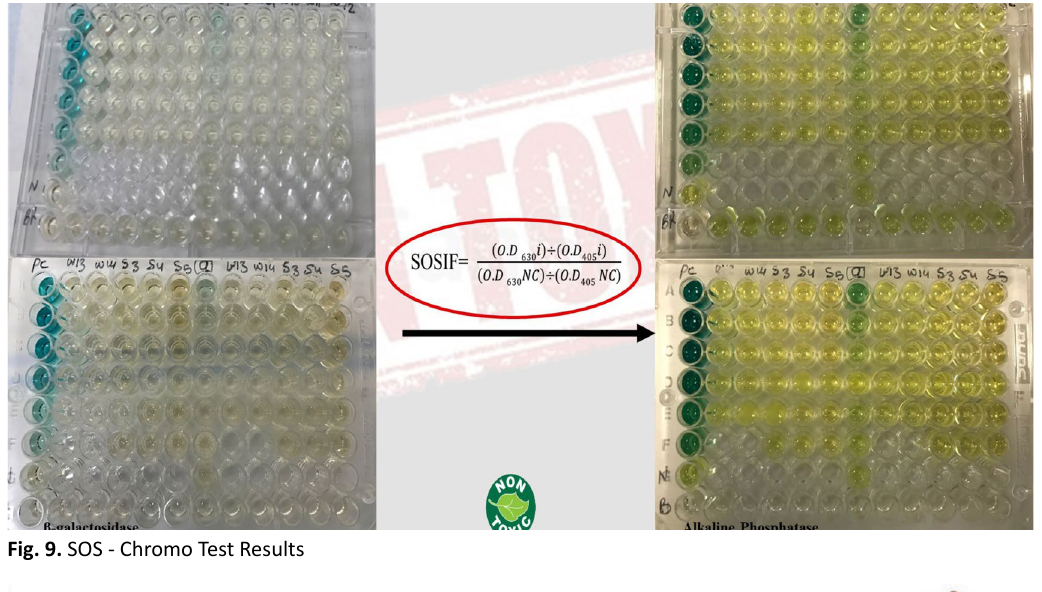
Fig. 9. SOS - Chromo Test Results